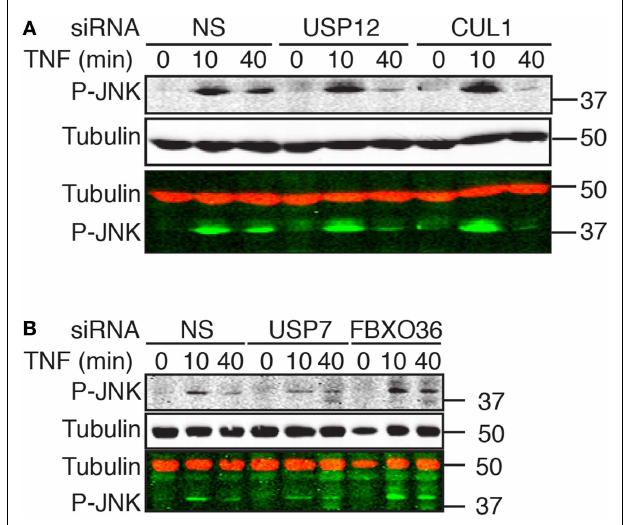
FIGURE 9 |Western blot evaluation of total phosphorylated JNK (P-JNK) in cells treated with the indicated siRNAs and incubated with TNF for the indicated times . In the merged images, P-JNK is shown in green and tubulin is shown in red. Molecular weights are shown in kilodaltons.